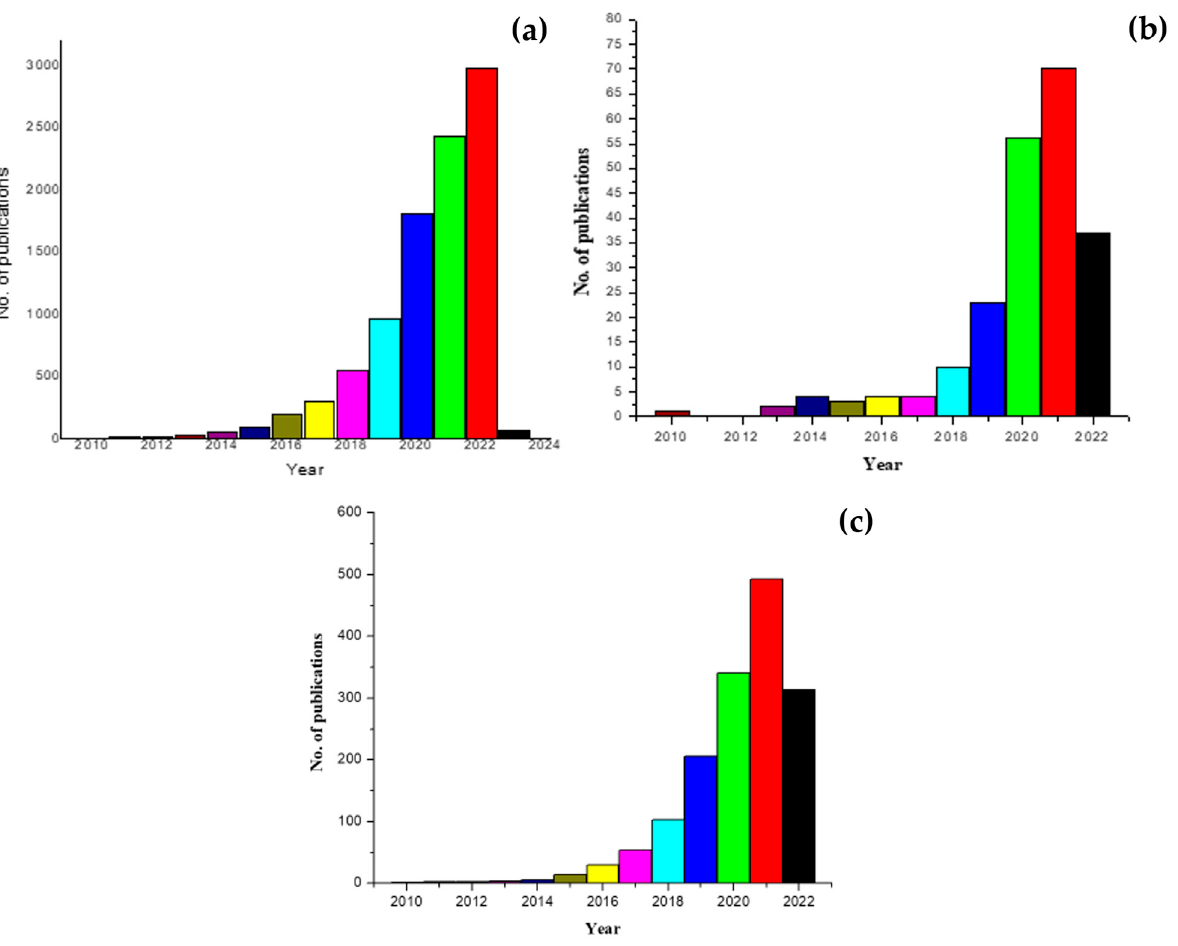
Figure 4 . Results of PubMed search on keywords such as, ( a ) ‘microplastics’, ( b ) ‘detection of microplastics’, and ( c ) ‘mass spectrometry and microplastics’.